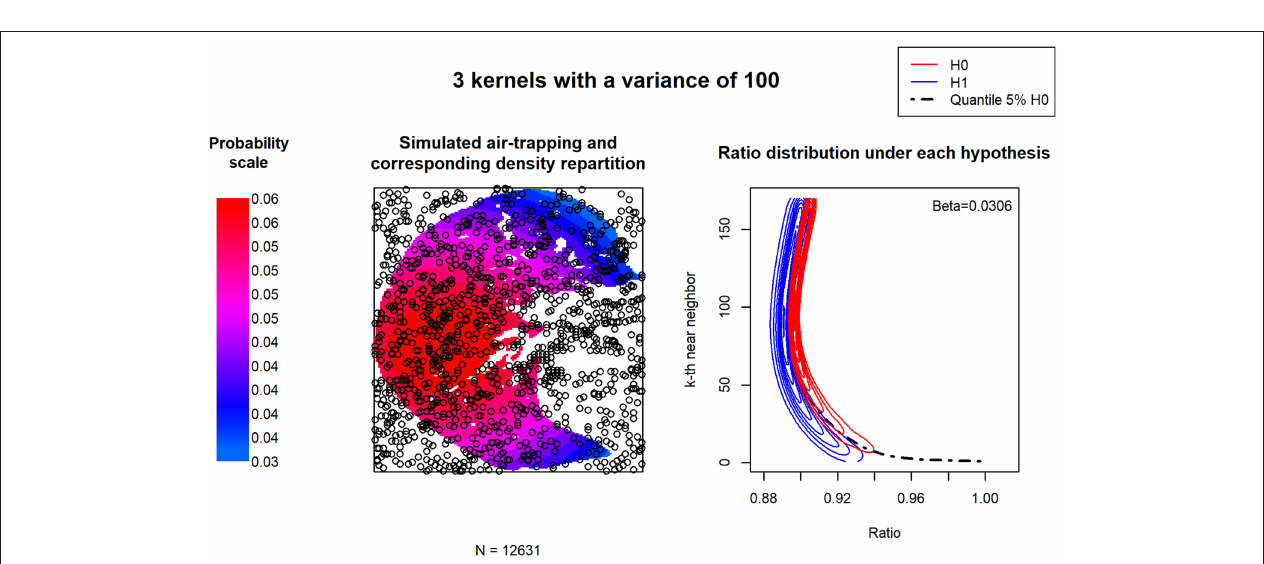
FIGURE 4 | UNDC ratios according to a homogeneous point pattern. Three kernels define the density of the simulated air trapping. The relatively high associated variance simulates homogeneous air trapping throughout the image. The density repartition of the R k curves is presented for 500 simulations.